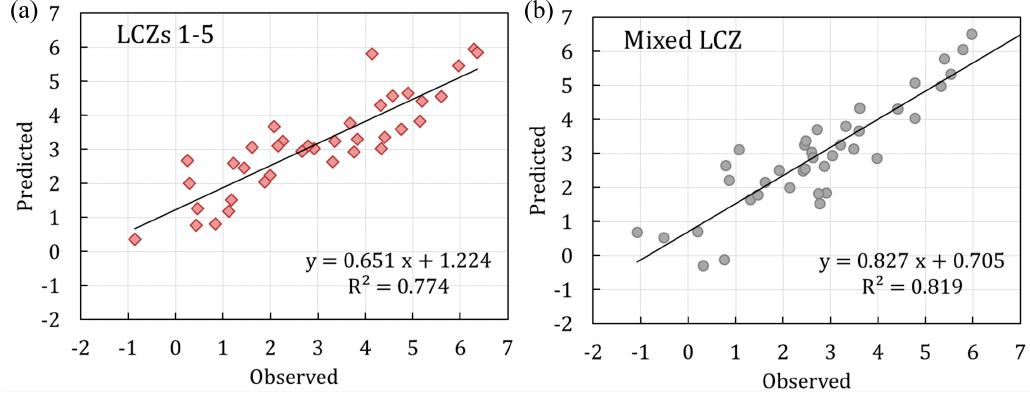
Figure 10. Observed versus predicted SUHI values for ( a ) LCZs 1–5 and ( b ) the mixed LCZ models. The linear regression with solid lines are shown.